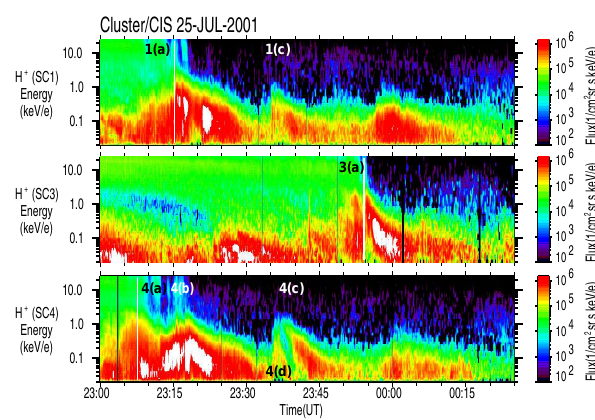
Fig. 12. Cluster CIS observations for the cusp crossings on 25 July 2001. Plotted are H + omni-directional flux measurements (1/cm 2 ssrkeV/e) for Cluster 1, 3, and 4. All spacecraft encounter distinctive structures with sudden jumps in the ion energy disper- sion that are similar on Cluster 1 and 4, but different on the later arriving Cluster 3. (From Trattner et al.,